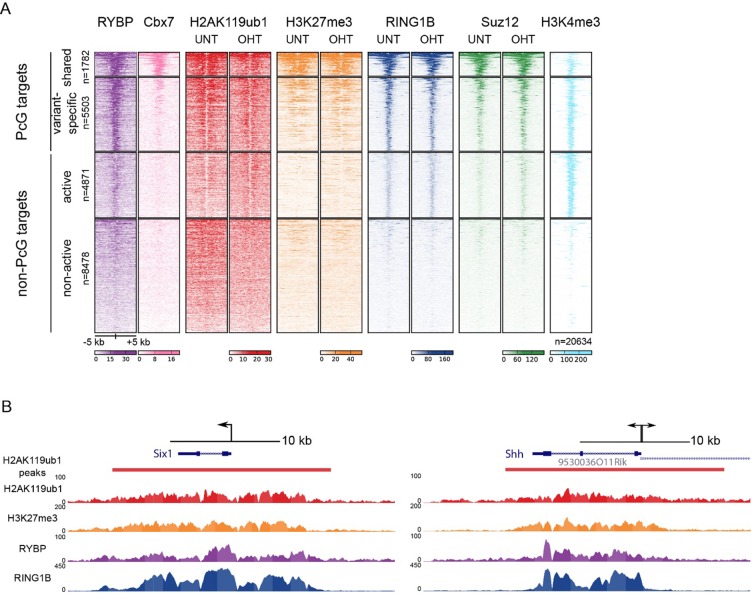
TSS clustering and heatmap analysis of variant and canonical PRC1.(A) Non-redundant mm10 refGene TSSs (n=20634) were clustered into Polycomb (PcG) or non-PcG TSS. These were then further clustered based on RYBP and CBX7 binding (Morey et al., 2013) into shared (RYBP and CBX7 aka variant and canonical PRC1) and variant-enriched (RYBP-enriched) TSSs. Non-PcG TSSs were clustered by H3K4me3 to identify in active and inactive TSS. (B) Genomic snapshot of Six1 and Shh TSSs. A fixed window of ± 5kb is depicted from the TSS (arrow). This simple windowing suffers from the fact that it does not capture the true polycomb chromatin domain. In contrast intervals based on H2AK119ub1 more accurately represent the region corresponding to the polycomb chromatin domain.